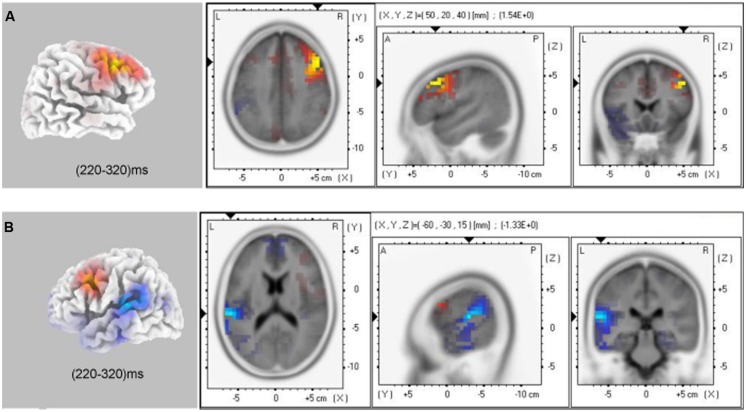
sLORETA solutions to non-parametric randomization tests on N2 components showing voxels in which the CON group > GAD group contrast (A) and GAD group > CON group contrast (B) were significant (P < 0.05; GAD, general anxiety disorder; CON, control).